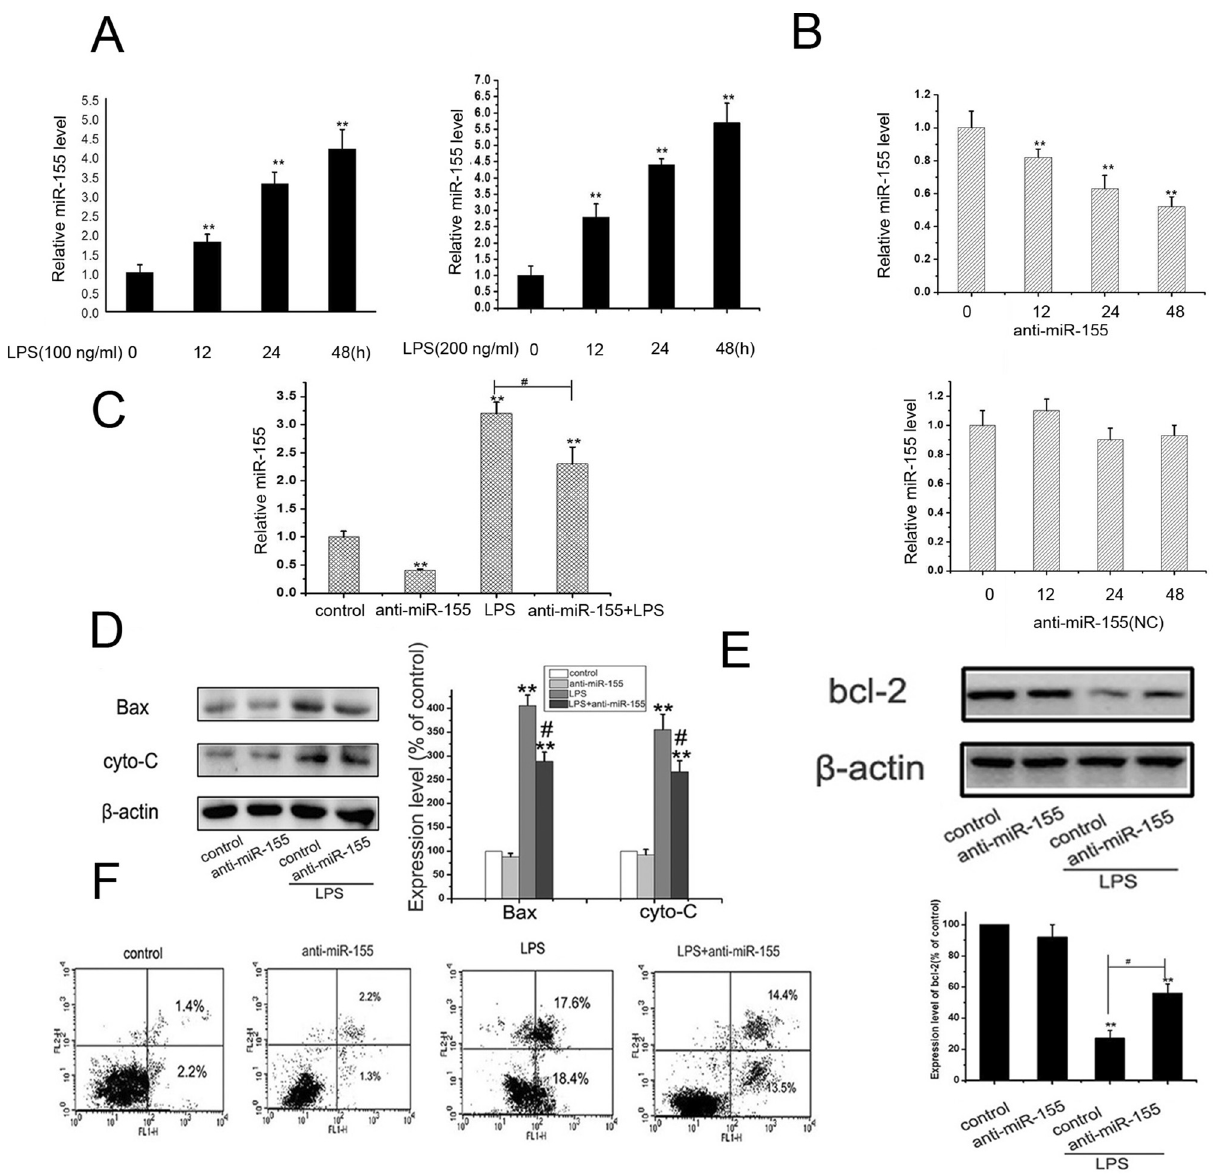
Figure 3 - Knock-down of miR-155 inhibited LPS-induced cell apoptosis. (A) MC3T3-E1 cells were cultured with 100,200 ng/ml LPS for 0, 12, 24 and 48 h, and the level of miR-155 was detected by qRT-PCR, U6 was as the loading control. The data were mean (cid:6) SEM (n=5). (** P<0.01, vs. 0 h group) . (B):miR-155inhibitorandinhibitorcontrol(NC)weretransfectedusingLipofectamine 3000andculturedfor0,12,24and48handthelevelofmiR-155 was detected by qRT-PCR, U6 was as the loading control. The data were mean (cid:6) SEM (n=6). (** P<0.01, vs. 0 h group). (C): MC3T3-E1 cells were transfectedwithmiR-155inhibitorsandculturedfor24h.Then,thecontrolcellsandanti-miR-155cells(aftertransfectionfor48h)wereculturedwithor without200ng/mlLPStreatmentfor24handthelevelofmiR-155mRNAwasdetectedbyqRT-PCR.U6wasastheloadingcontrol.Thedataweremean (cid:6) SEM (n=6). (** P <0.01, vs. control group; # p<0.01 LPS group vs. LPS+anti-miR-155 group). (D,E) Cells were treated as aboved, western blots were performed with the antibodies indicated. Relative expression of Bax, cytochrome c and bcl-2 were calculated and normalized to the loading control (cid:2) -actin. The data were mean (cid:6) SEM (n = 6). (** P < 0.01, vs. control, # P < 0.05, LPS vs. LPS+anti-miR-155 group) . (F) Induction of apoptosis in LPS-induced cells was detected with annexin V-FITC/PI double staining. Results are representative of three